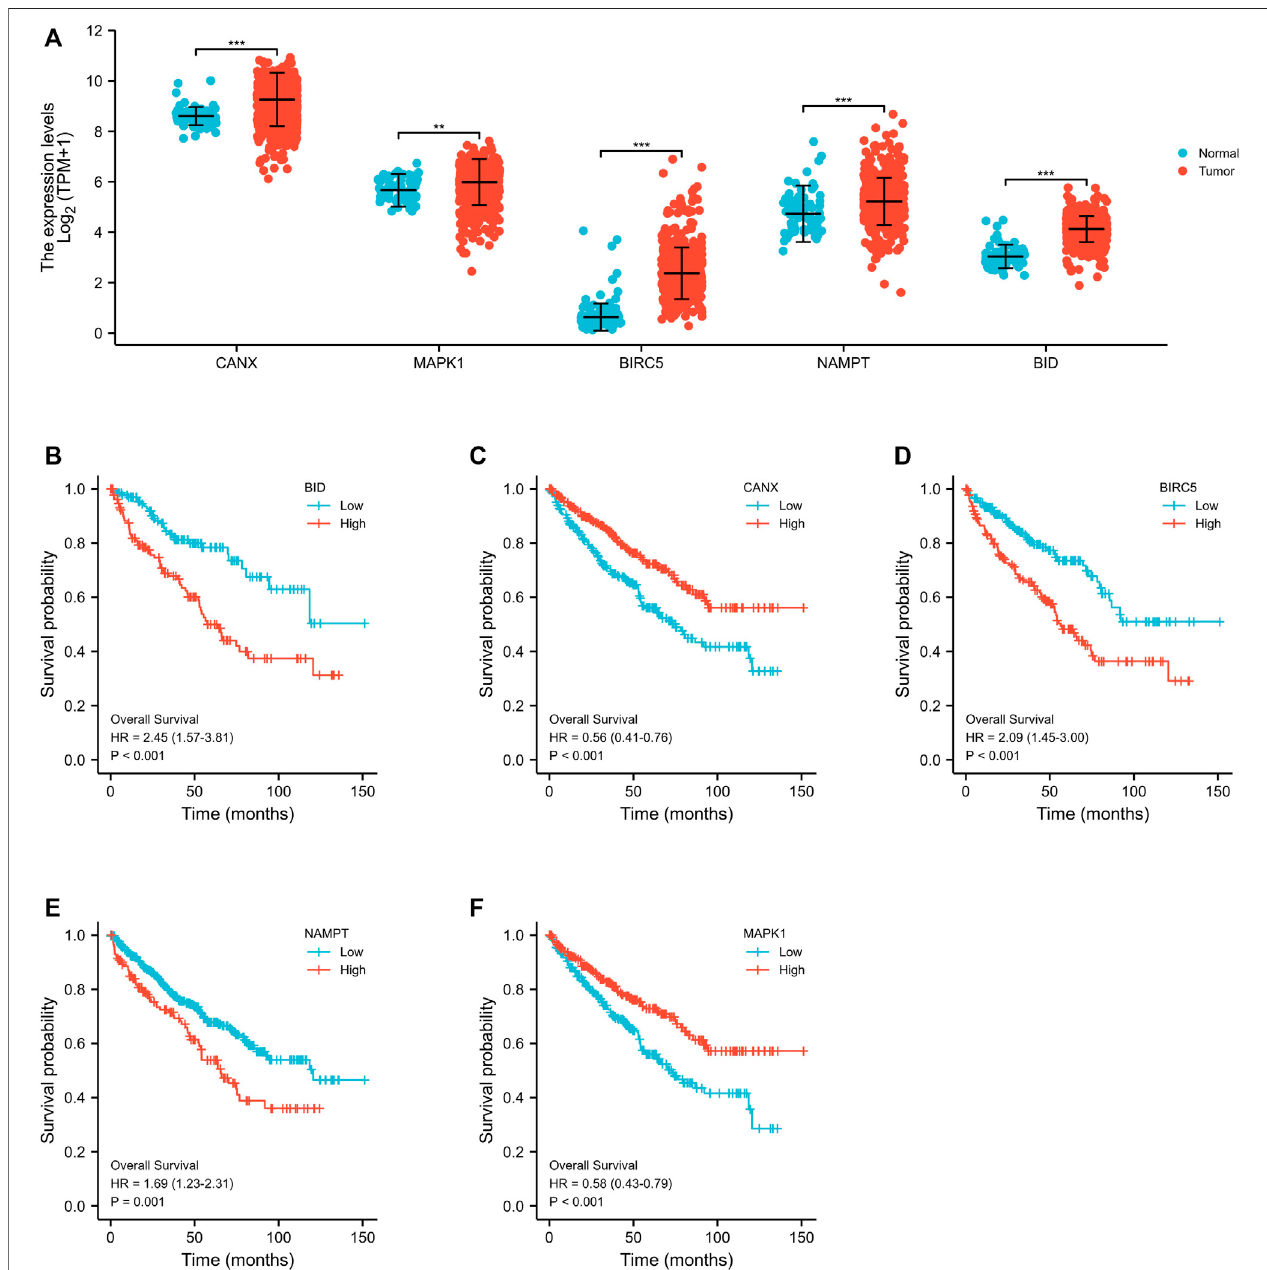
FIGURE 2 | Differential expression and survival analyses of immune-autophagy genes in kidney renal clear cell carcinoma (KIRC). Expression pro fi le of the fi ve immune-autophagy genes in KIRC samples compared with normal tissues (A) . Kaplan – Meier plots showing CANX, MAPK1, BIRC5, NAMPT, and BID with prognostic value (B – F)